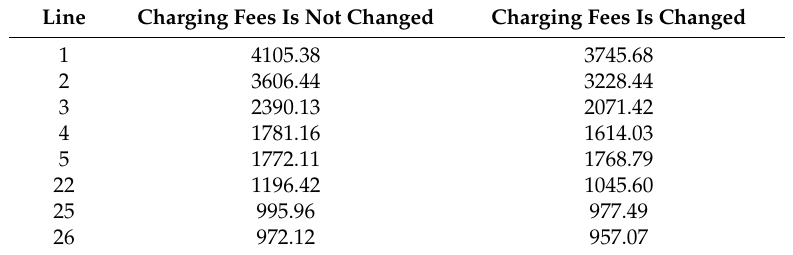
Table 6. Peak valley difference of active power of a line before and after adjustment for charging fees.